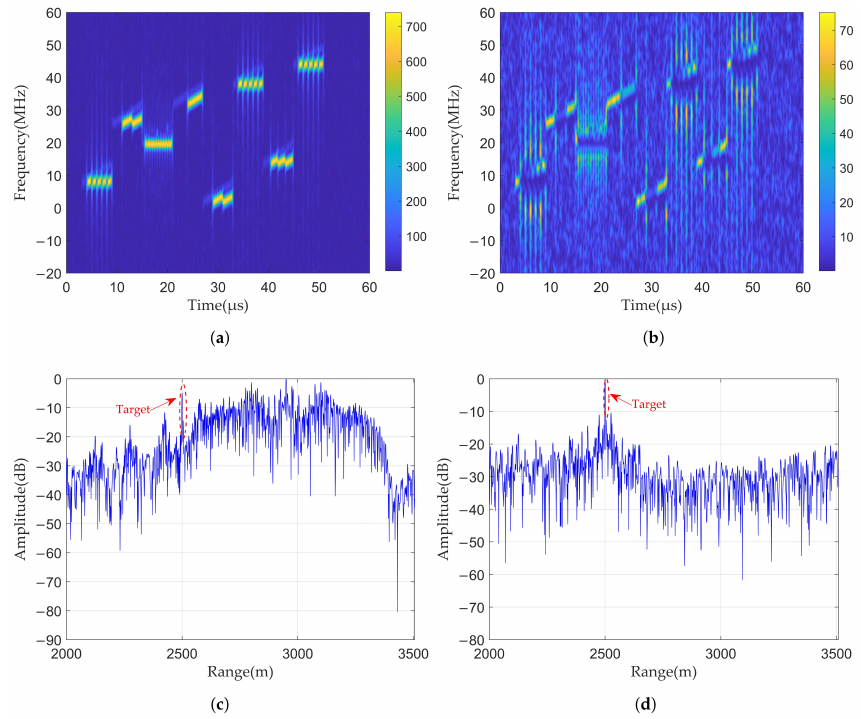
Figure 10. Suppression effect of Ref. [19] on NUISRJ: ( a ) time–frequency distribution before suppres- sion, ( b ) time–frequency distribution after suppression, ( c ) pulse compression before suppression, ( d ) pulse compression after suppression.